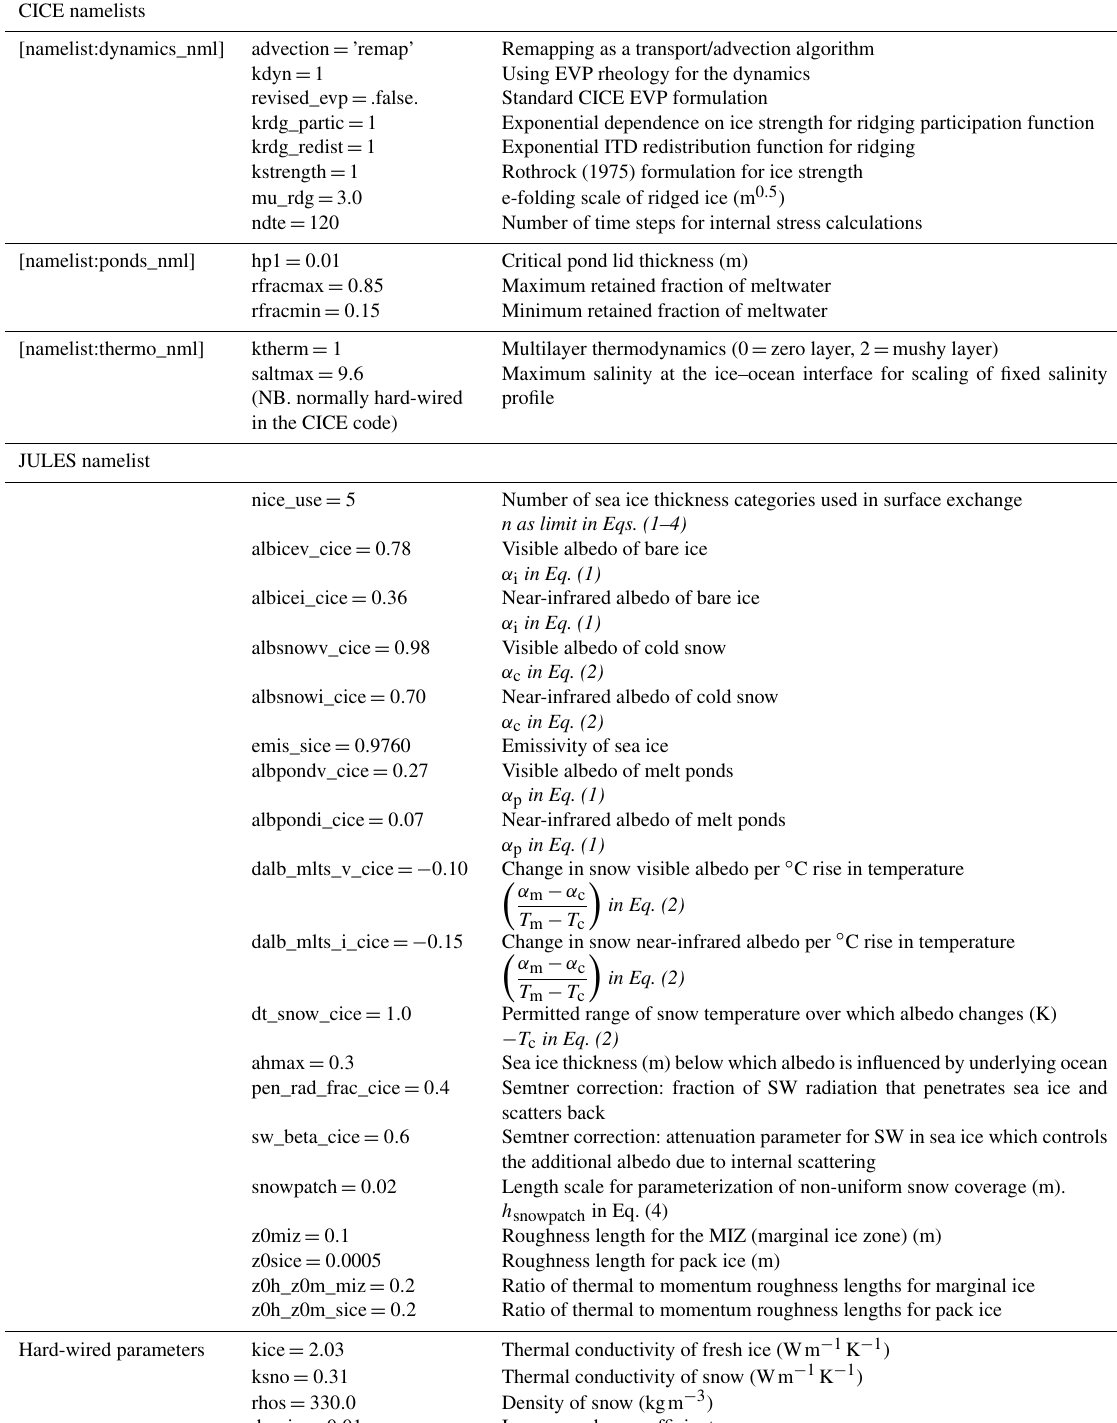
Table A1. GSI8.1 namelist options and hard-wired parameters used within CICE and